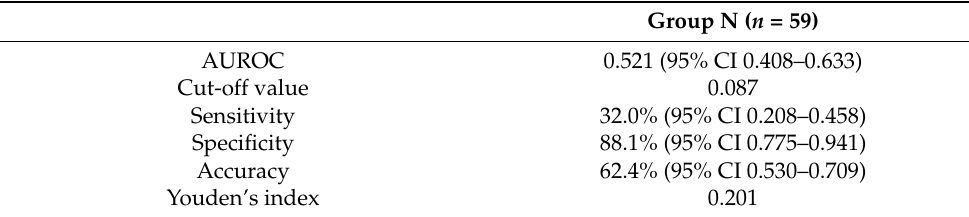
Table 3. Diagnostic assessment of the phase angle change ratio in